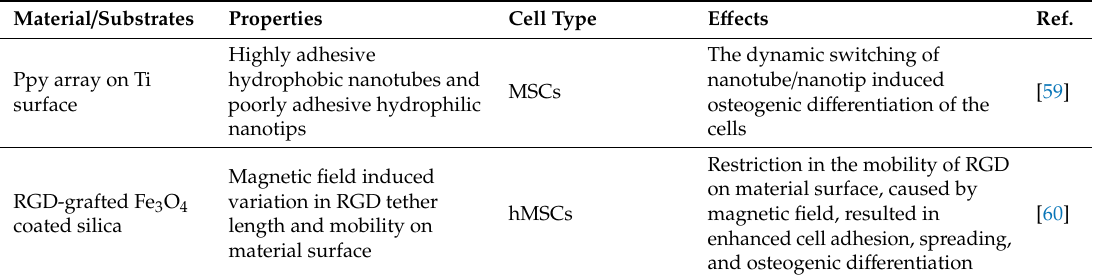
Table 3. Studies reporting the e ff ects of electric and magnetic field applied to culturing substrates on